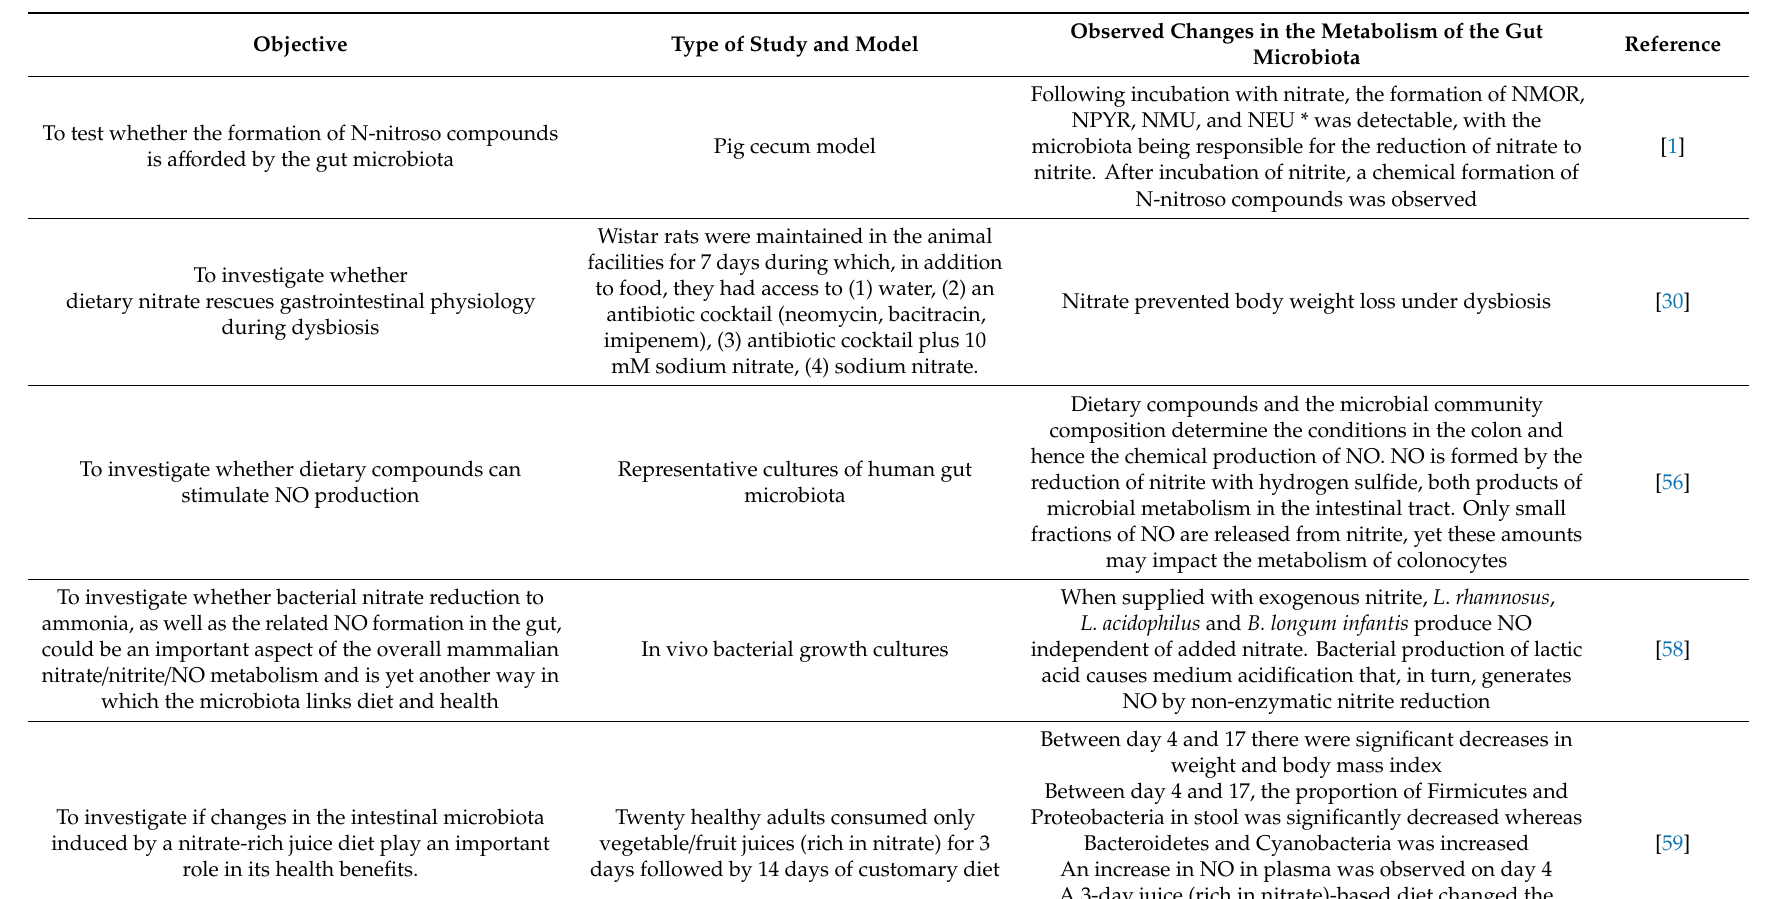
Table 2. Evidence on the e ff ect of dietary nitrate-based products on the gut